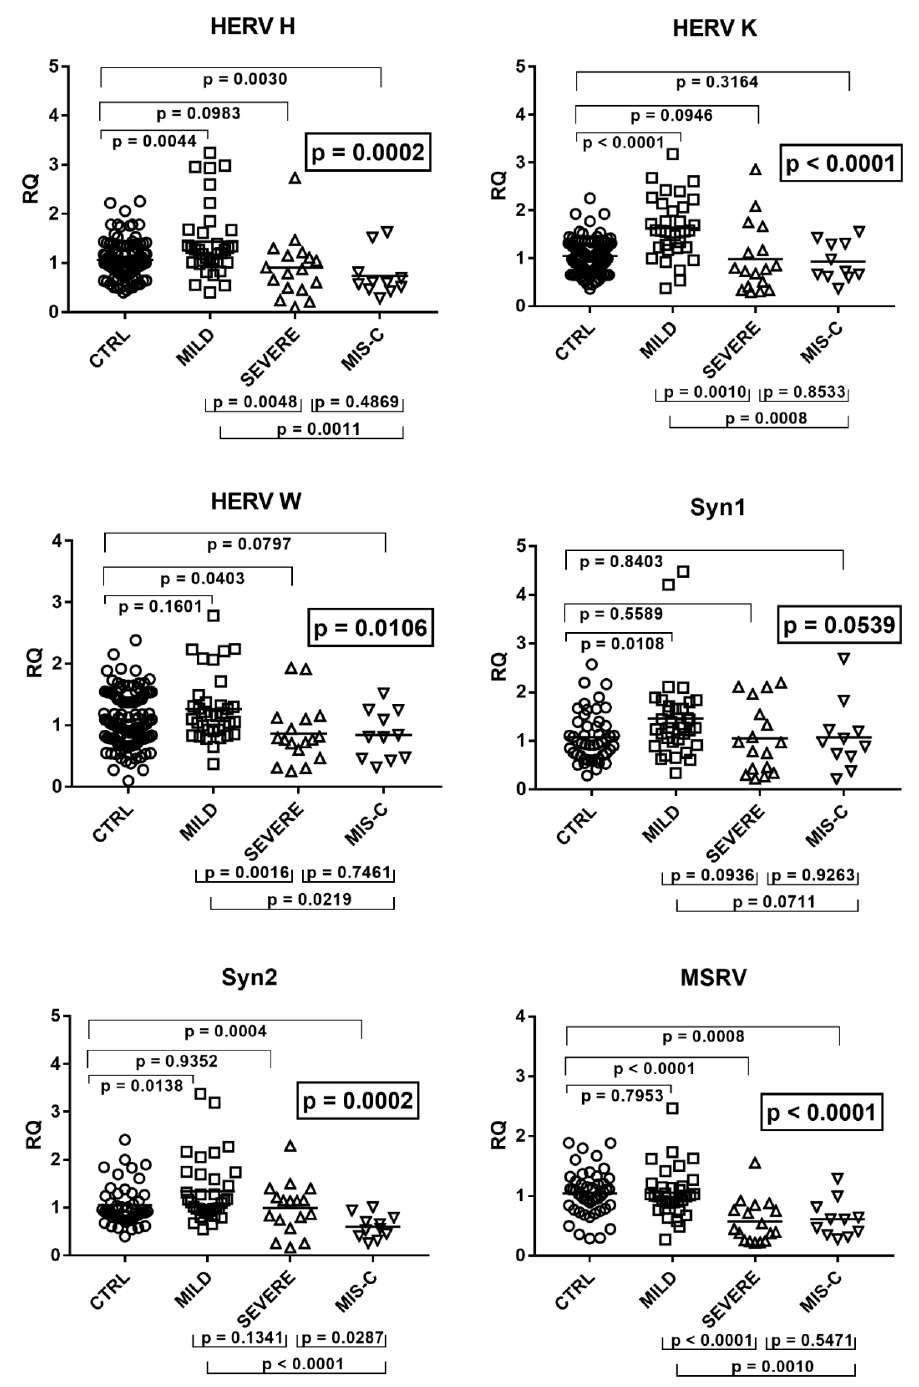
Figure 8. Transcription levels of pol genes of HERV-H, HERV-K, and HERV-W, and of env genes of SYN1, SYN2,